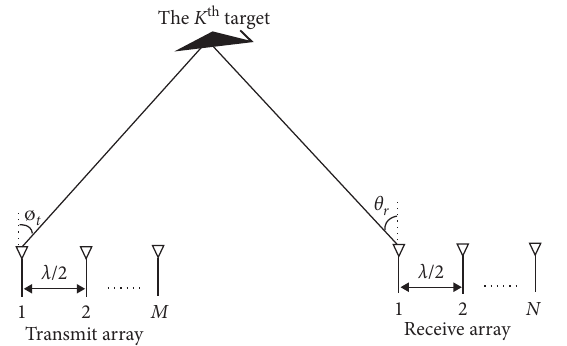
Figure 1: The bistatic MIMO radar system